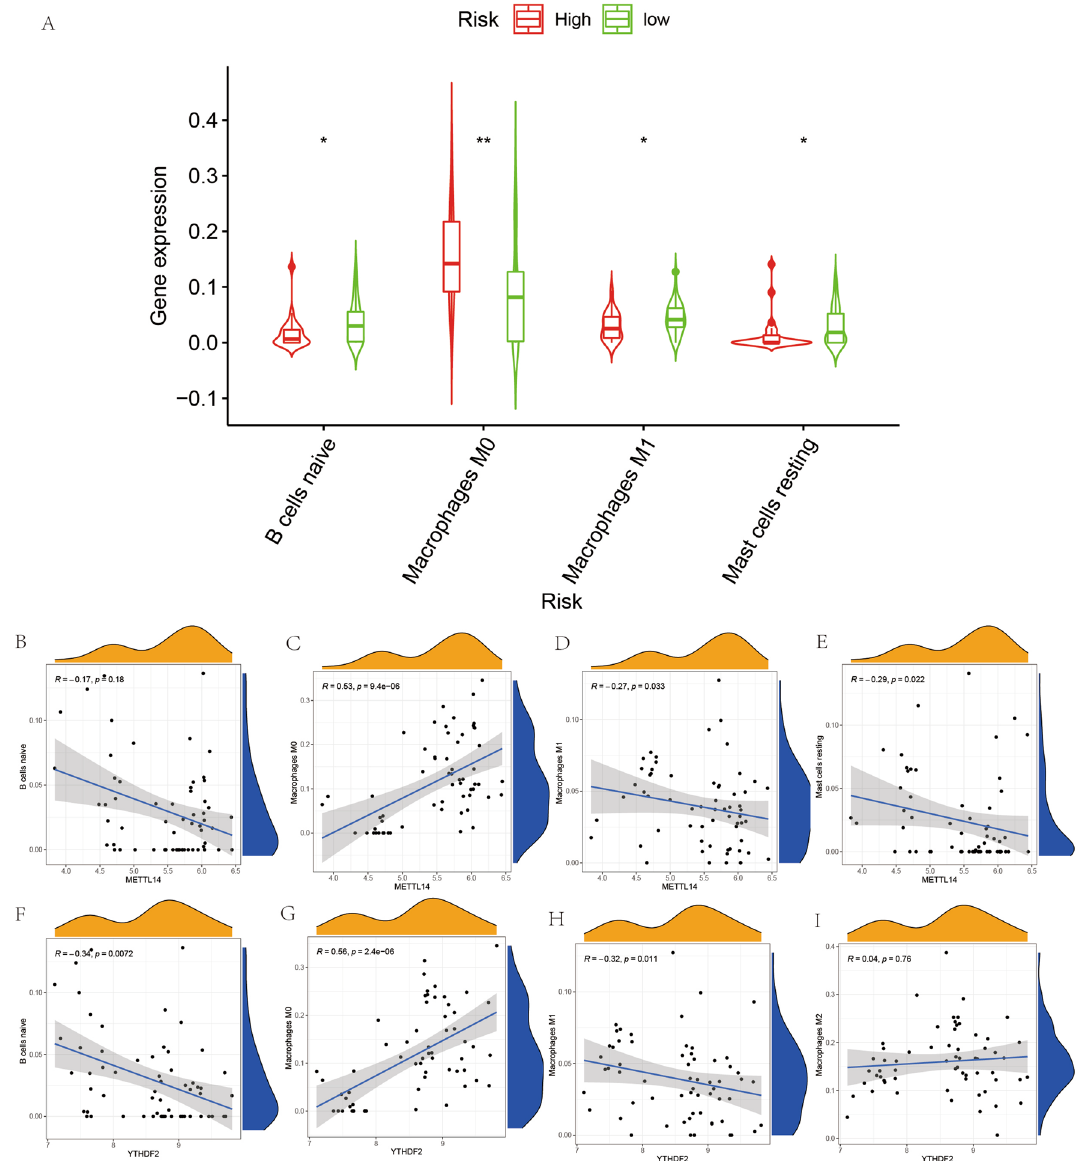
Figure 9. Expression of immune cells in Ewing’s sarcoma and paraneoplastic tissues. Figure A shows the expression of four immune cells in Ewing’s sarcoma and paraneoplastic tissues, "*" indicates P < 0.05, "*" indicates P < 0.01. ( B – E ) represent the correlation analysis obtained between METTL14 and this B cells naive, Macrophages M0, Macrophages M1 and Mast cells resting. ( F – H ) and ( G ) represent the correlation analysis obtained between YTHDF2 and this B cells naive, Macrophages M0, Macrophages M1 and Mast cells